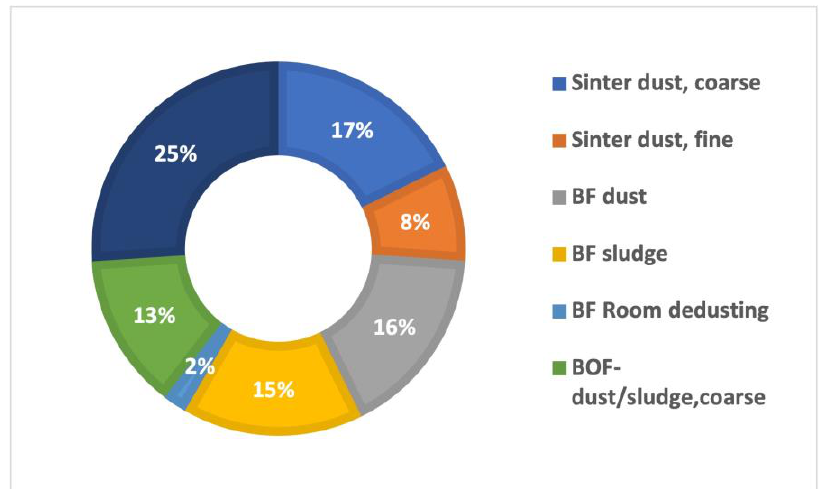
Figure 5. Production of dust/sludge BF in 2018.